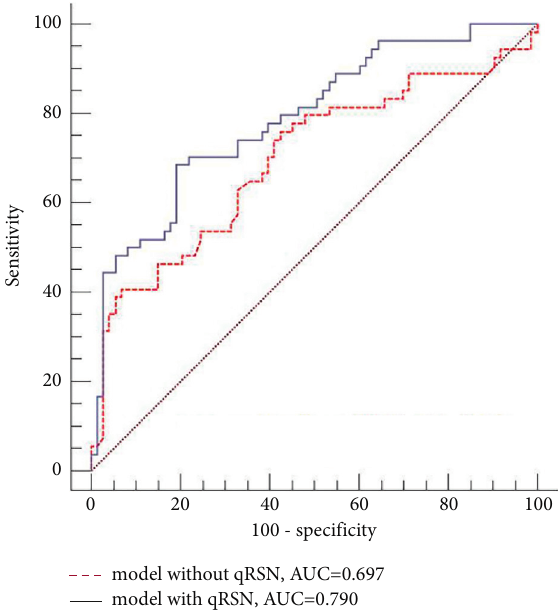
Figure 6: Comparison of receiver characteristic curves of models with and without qRSN for differentiating the renal injury group from the control group. The area under the receiver operating characteristic curve in the logistic regression model combined with qRSN was larger than that in the model without qRSN ( Z � 2.314, P � 0 .